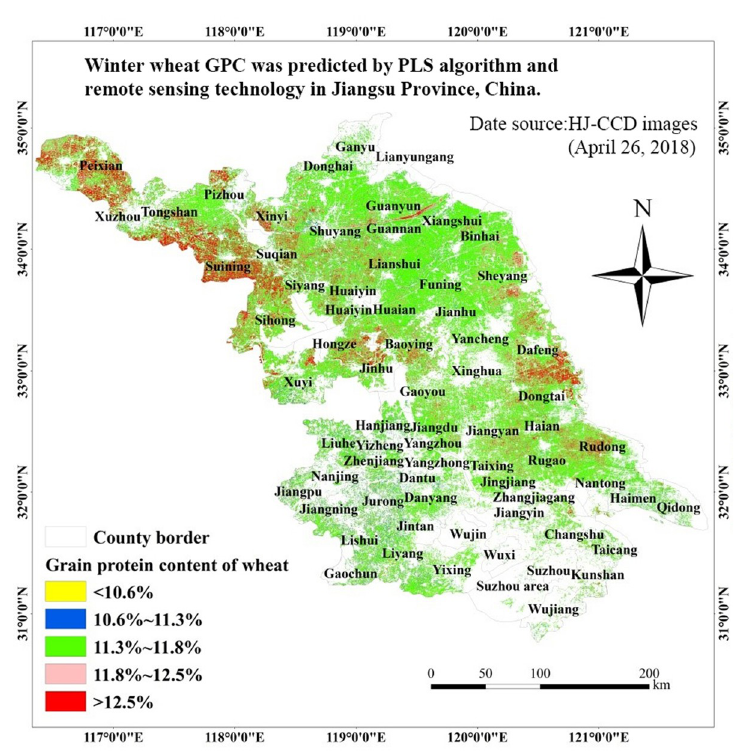
Fig 3. Spatial distribution of winter wheat GPC in Jiangsu